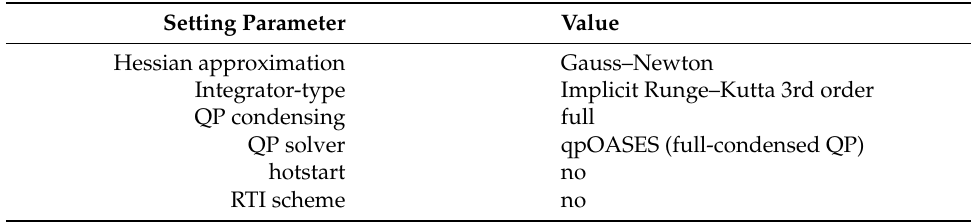
Table 4. NMPC—MATMPC toolbox settings